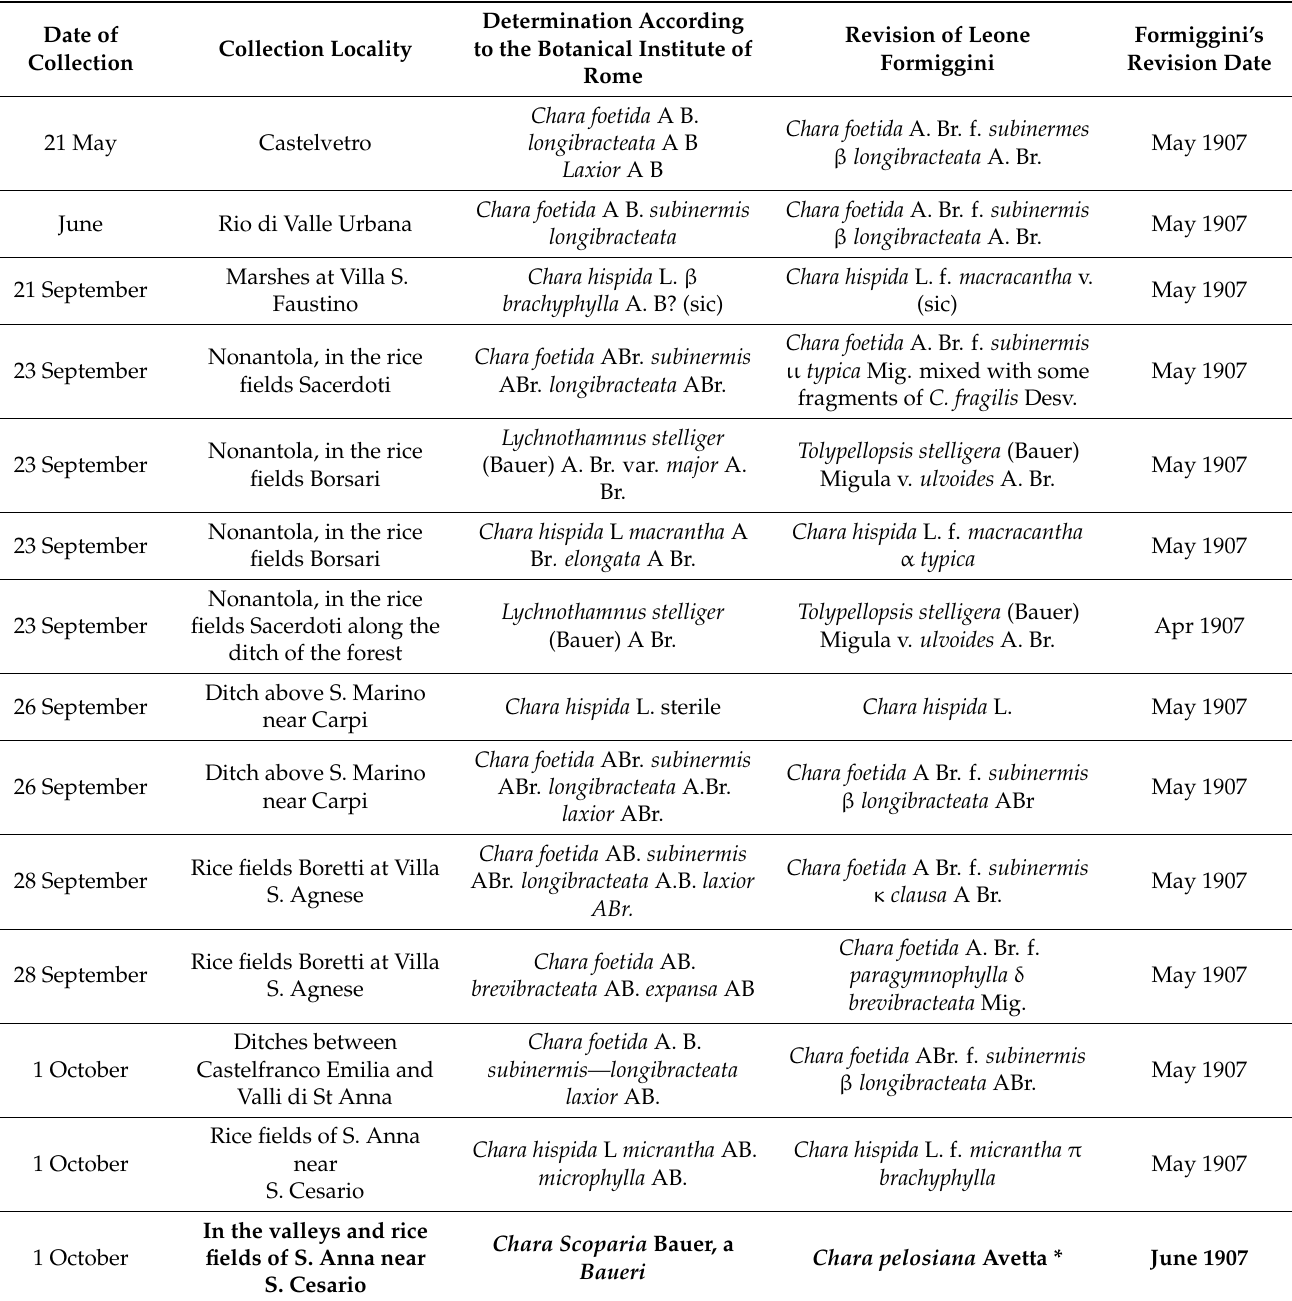
Table 1. Duplicate of Ferrari’s Characeae collection from the Modena Herbarium (MOD). The specimens, collected in the Modena area in 1886, are listed in chronological order. For the abbreviations of names and authors, we reproduced the original labels. The Chara pelosiana specimen revised by Formiggini is marked in